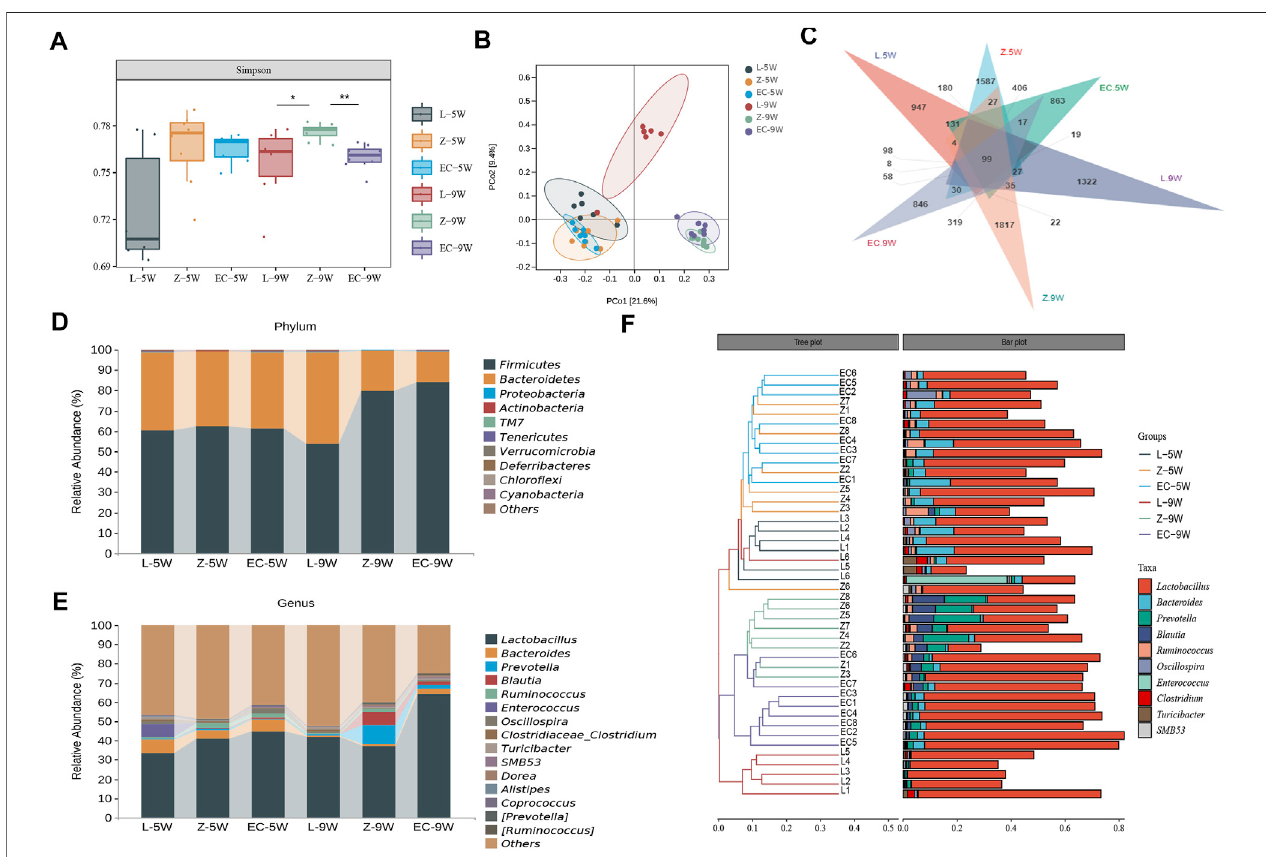
FIGURE 4 | ECD modulated the overall structure and composition of gut microbiota in ZDF rats. Gut microbiota among groups at 5 and 9 weeks of age. (A) Simpson diversity. The Kruskal-Wallis rank sum test and Dunnett ’ s test were used as post hoc tests to verify the signi fi cance of the difference. * p < 0.05, ** p < 0.01. (B) PCoA based on unweighted UniFrac distance. The ellipse con fi dence was 0.95. (C) ASV Venn diagram. (D, E) Gut microbiota composition at phylum and genus levels. (F) Hierarchical clustering analysis at the genus level. The left panel is a hierarchical clustering tree diagram and the right is a stacked column chart of